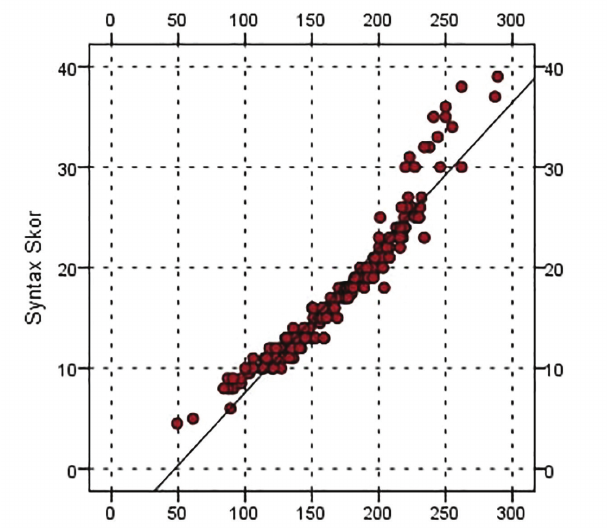
Figure 1 - Correlation of SYNTAX score with